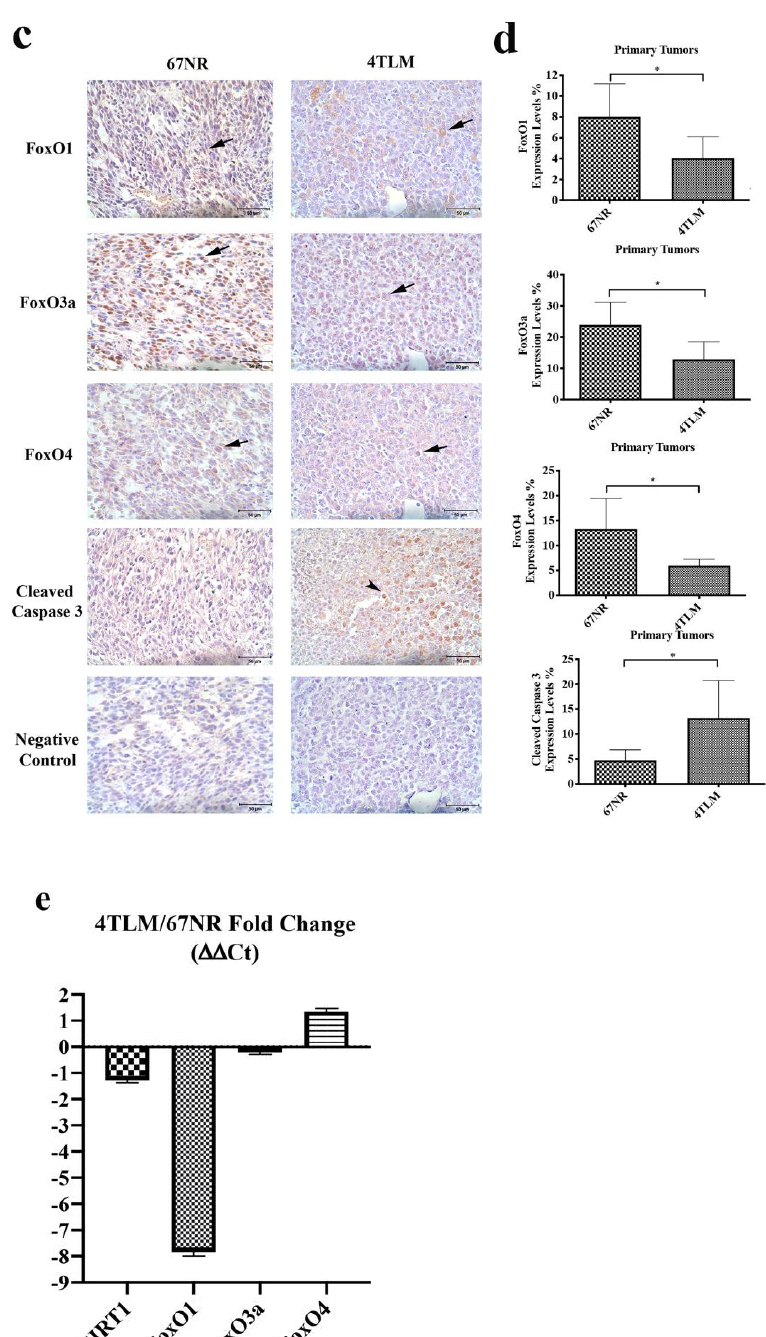
Figure 2. Expression of SIRT1, p53, p21, E2F1 and FoxO proteins, as well as cleaved caspase 3, in 67NR and 4TLM primary tumors. ( a ) Representative images showing the expression of SIRT1, p53, p21 and E2F1 in 67NR and 4TLM primary tumors. Arrows represent target protein expression for each protein, and the arrowhead represents perinuclear E2F1 expression in 4TLM. Scale bar represents 50 µ m. ( b ) Graphs demonstrate the results of Image J analysis for each protein in primary tumor tissues (* p < 0.05). ( c ) Representative images showing FoxO1, FoxO3a, FoxO4 and cleaved caspase 3 protein expression in 67NR and 4TLM primary tumors. Arrows represent target protein expression for each protein, and the arrowhead represents nuclear cleaved caspase3 expression in 4TLM. Scale bar represents 50 µ m. ( d ) Graphs demonstrate results of Image J analysis for each protein in primary tumors (* p < 0.05). ( e ) The graph represents mRNA levels of SIRT1, FoxO1, FoxO3a and